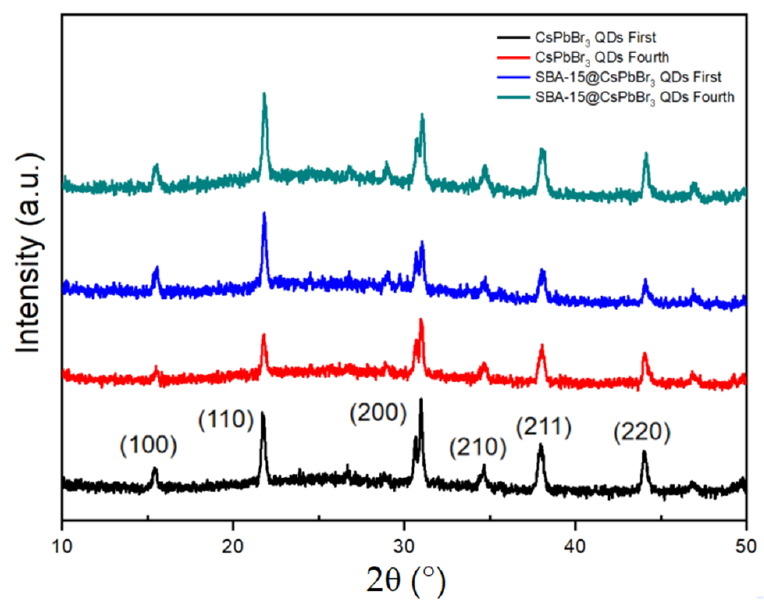
filled with QD solution and sealed all the gaps with epoxy-based glue. Finally, monochro- matic QD-LEDs were fabricated by integrating the sealed glass box with UV LED chip (emission peak at 365 nm). Figure 8. XRD pattern of pure CsPbBr 3 QDs and SBA-15@CsPbBr 3 QDs after heating and cooling.